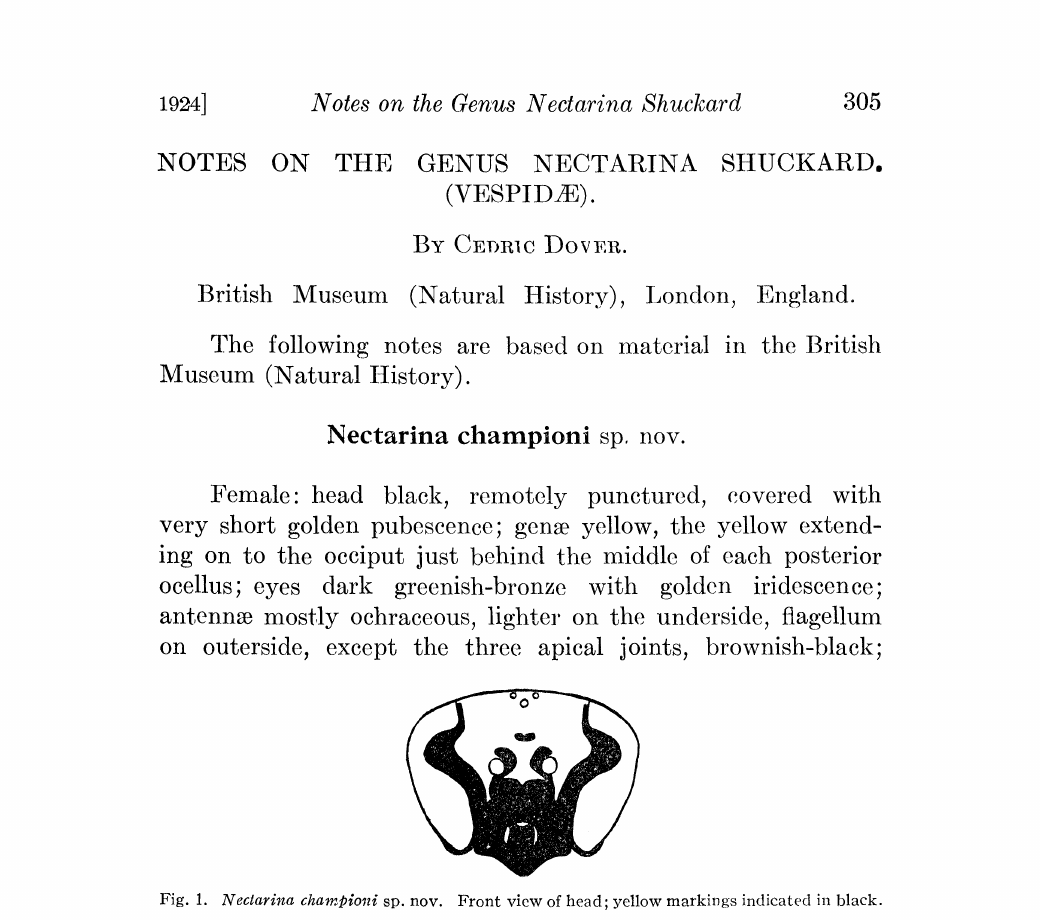
Fig. 1. Nectarina champoni sp. nov. Front view of head; yellow markings indicated in